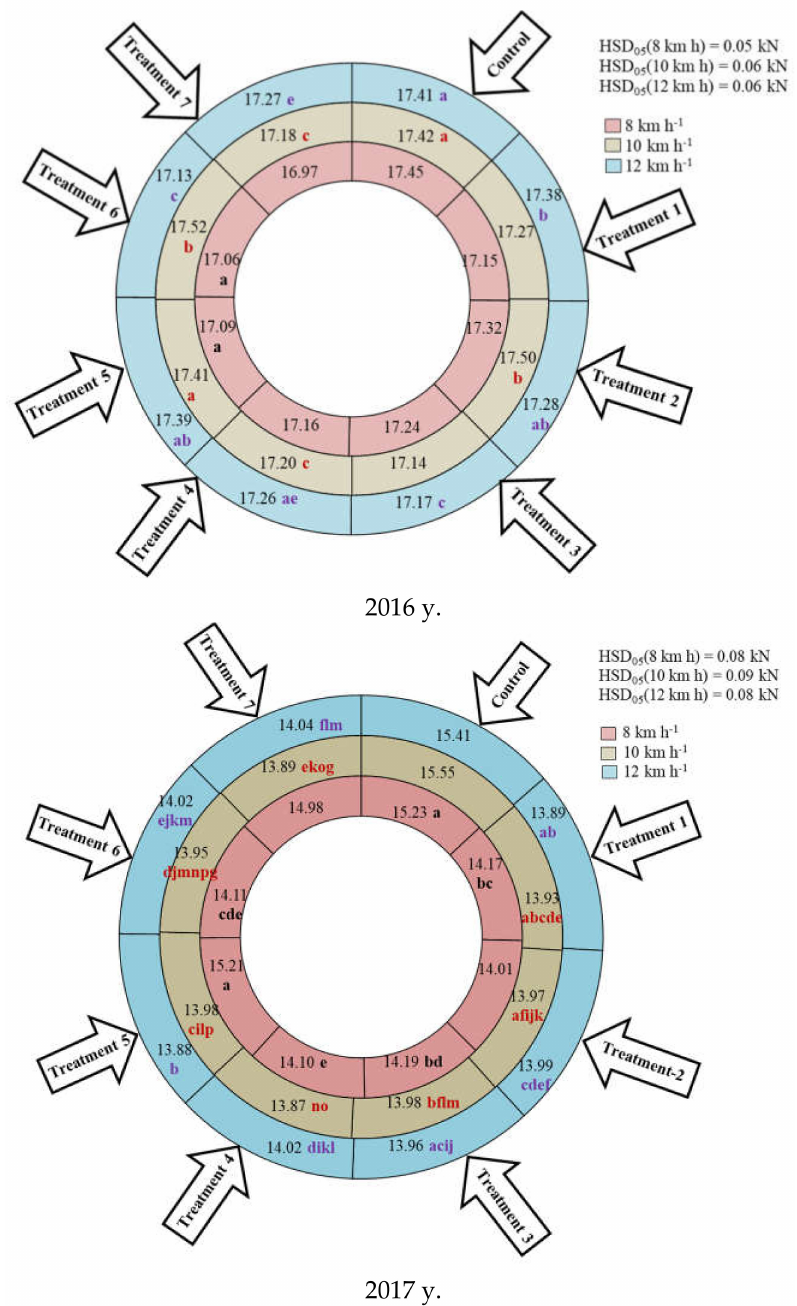
Figure 5. The impact of different biopreparations and driving velocities on the traction force of a shallow tillage machine: Treatment 1—composition of the biopreparation No. 1; Treatment 2—No. 1 and No. 2 mixture; Treatment 3—composition of the biopreparation No. 2; Treatment 4—No. 1 and No. 3 mixture; Treatment 5—composition of the biopreparation No. 4; Treatment 6—No. 1 and No. 4 mixture; Treatment 7—composition of the biopreparation No. 3. Letters with the same color indicate no significant difference between different variants the same